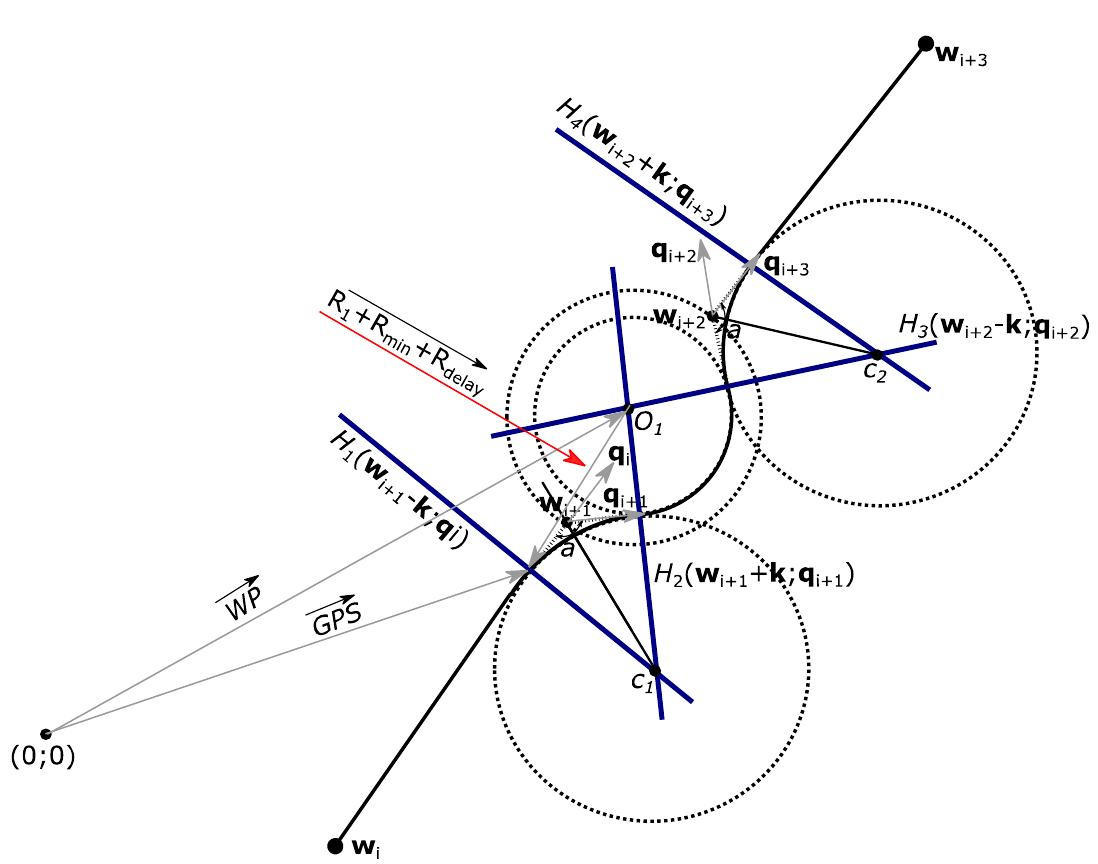
Figure 3. Additional waypoint and planes for one flight mission segment to safely fly around ground obstacle O 1 .